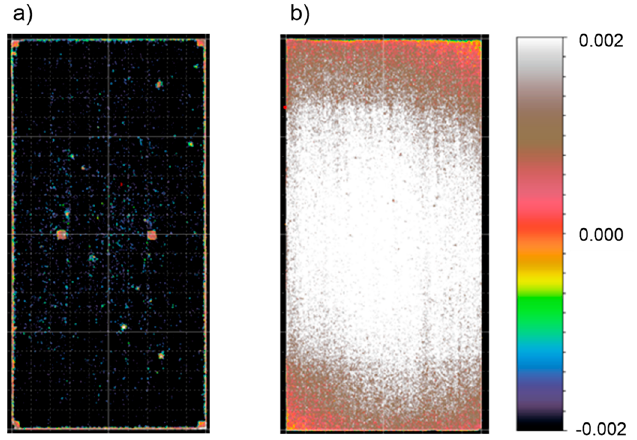
Figure 17. Deformation map of spot-glued panels obtained from 3D scanner readings. ( a ) C-type panel, ( b ) B-type panel.